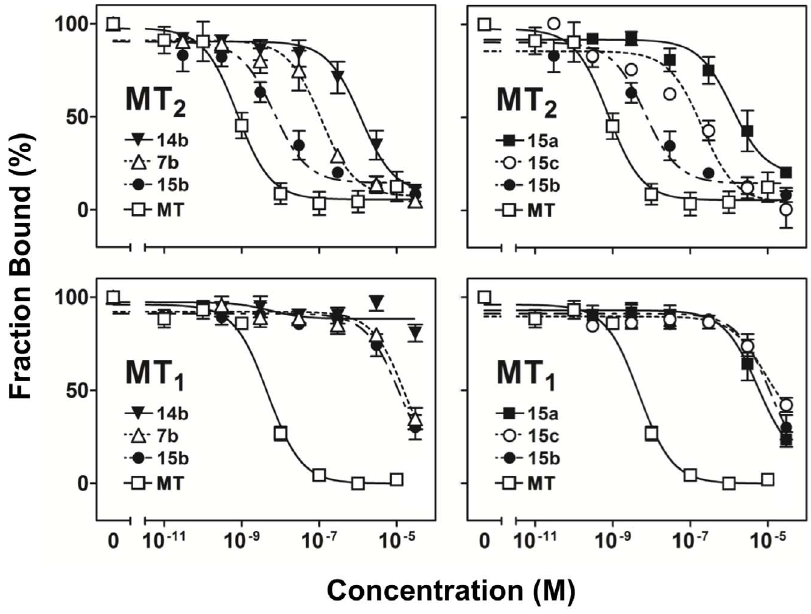
Figure 3. Competitive receptor binding curves of selective isoquinolinone derivatives. Intact CHO cells expressing MT 1 or MT 2 were incubated with [ 3 H]melatonin with or without different concentrations of selected tested compounds or unlabeled melatonin. Data represented mean ¡ SEM of at least 3 different trials performed in duplicates, and normalized to the maximal binding values (in the absence of tested compound). Estimation of maximal displacement and IC 50 and K i were shown in Table